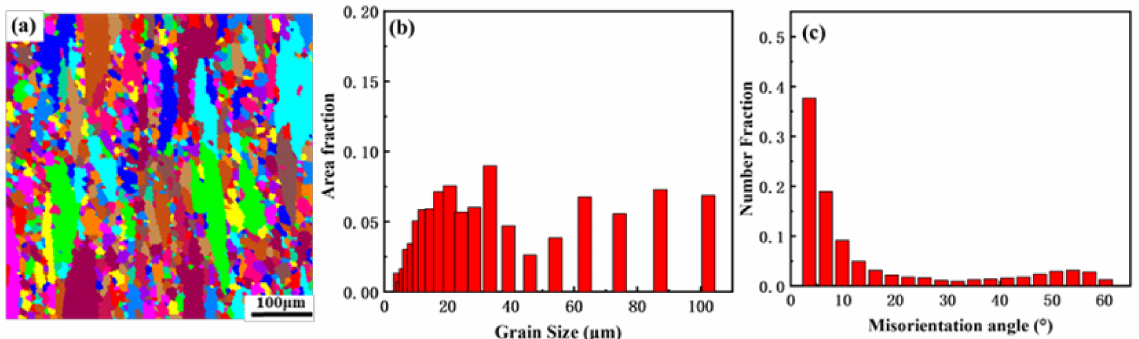
Figure 7. ( a ) Grain structure, ( b ) histogram of grain size and ( c ) histogram of the misorientation angle of the sample annealed at 350 ◦ C after thermal cycling (N =